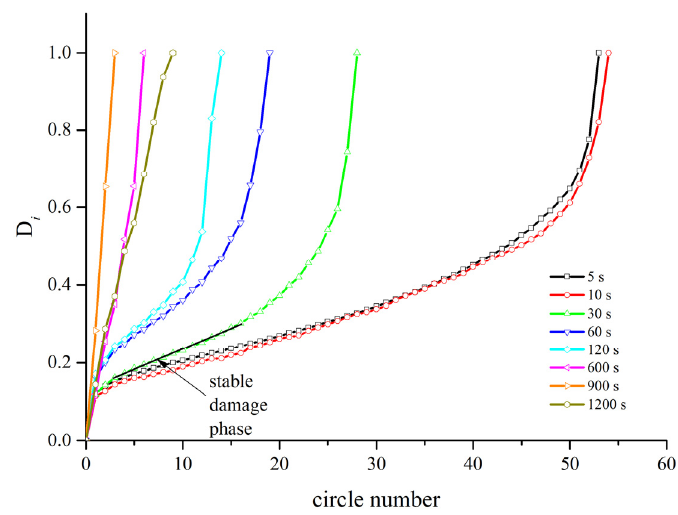
Figure 13. Accumulated damage curves-D i .